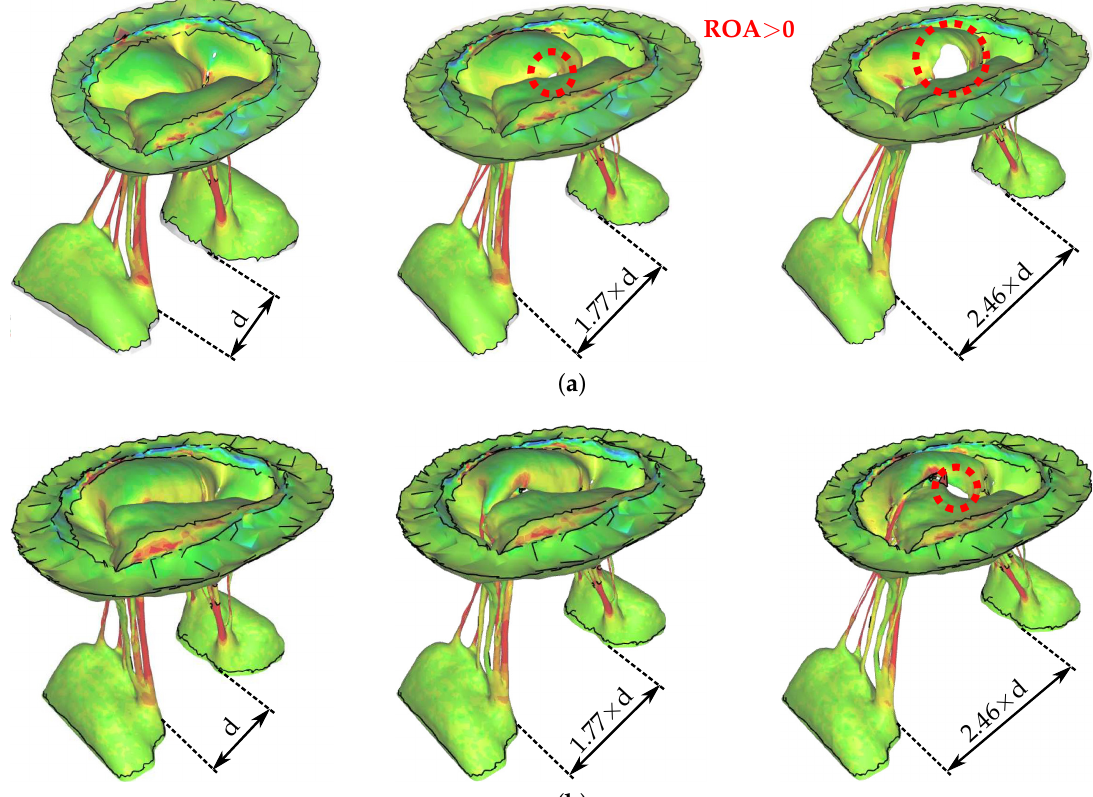
Figure 4. The effect of edge-to-edge (E-to-E) repair on the regurgitant orifice area (ROA) that resulted from dilated papillary muscles. ( a ) Without E-to-E repair. ( b ) With E-to-E